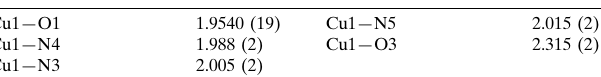
Selected bond lengths (A˚ ).